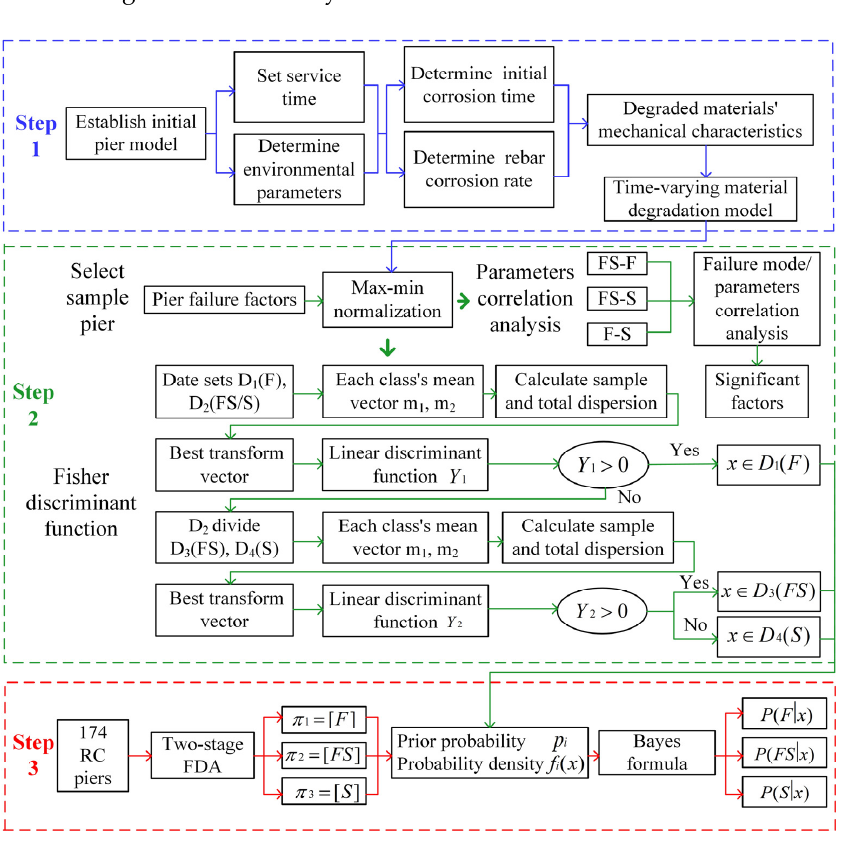
Figure 8. Flow chart of failure mode probability analysis of corroded bridge